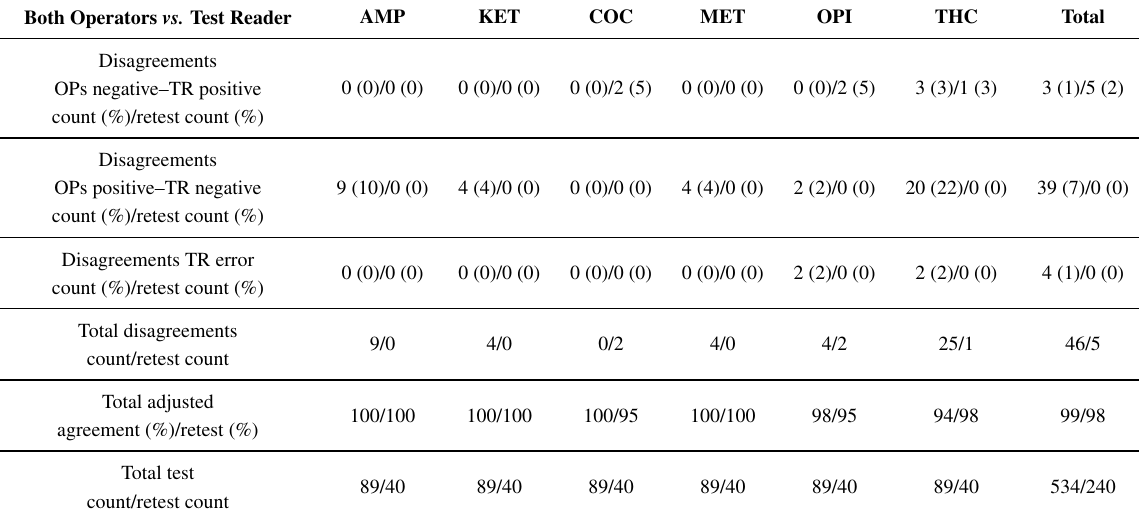
Table 6. Disagreement and adjusted agreement test results